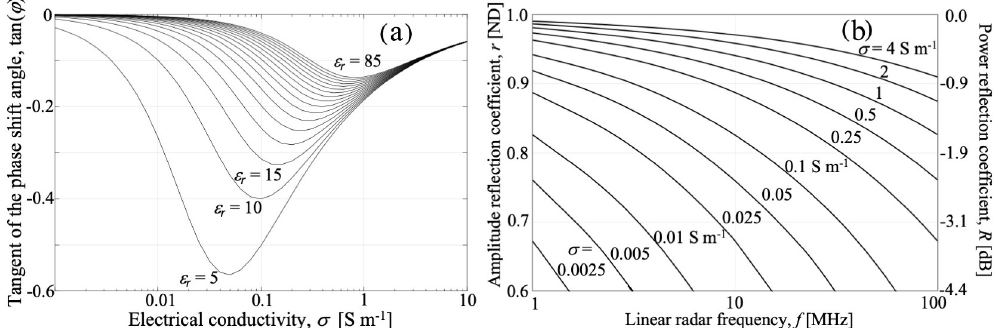
Figure 2. (a) An equivalent plot to Fig. 1d but here the tangent of the phase shift angle (Eq. 10) is plotted for the case of 100MHz linear frequency as a function of electrical conductivity and relative permittivity of the sub-ice material. The equivalent phase shift angles are given on the right axis. The material properties of ice are as assumed in Fig. 1d. (b) A plot demonstrating the frequency dependence of the high-loss version of the amplitude reflection coefficient, r (Eq. 12), for different values of electrical conductivity of the sub-ice material. The material properties of ice are as assumed in Fig. 1d. The right-hand-side axis gives the power reflection coefficient, R (Eq. 9), in